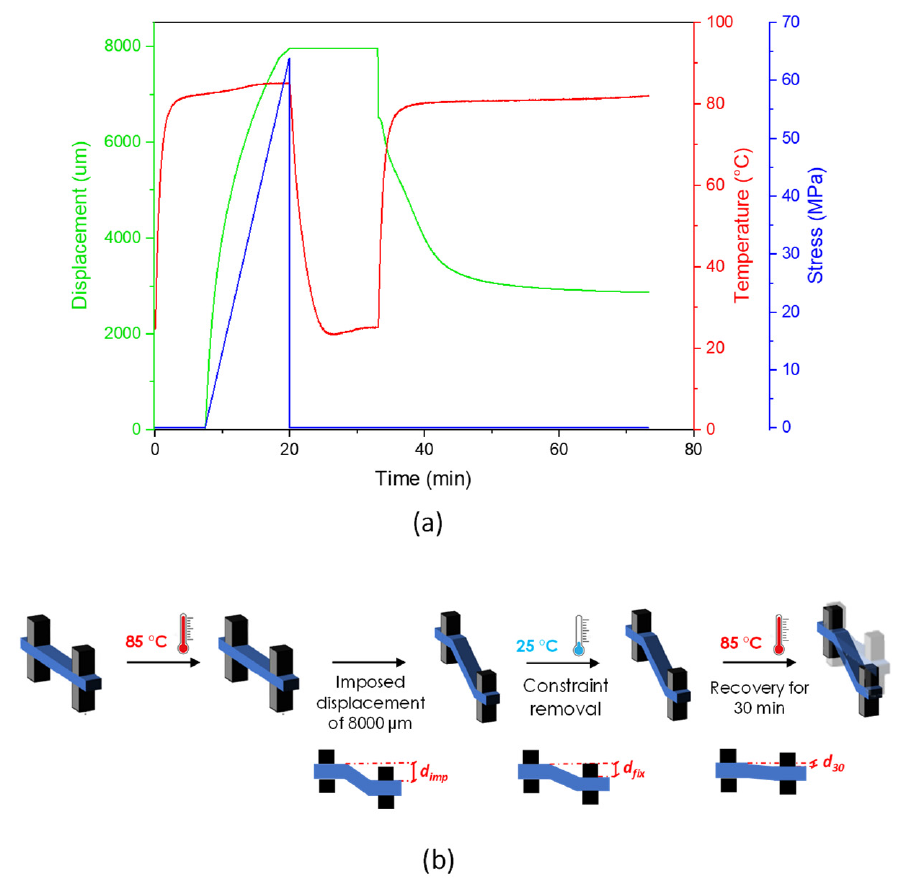
Figure 1. ( a ) Graphical representation, as an example, of PLA_PBAT_15 sample and ( b ) illustration of the thermomechanical cycle adopted to investigate the shape memory behavior of the PLA/PBAT blends.